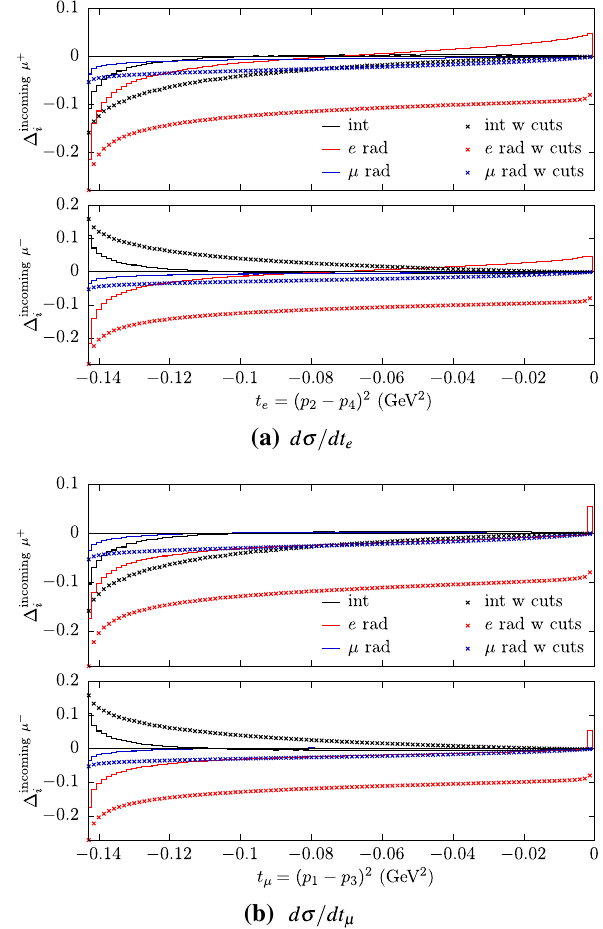
Fig. 13 The contribution of the QED gauge-invariant subsets to the cross section of the process μ + e − → μ + e − (upper panel) and of the process μ − e − → μ − e − (lower panel), as a function of the squared momentum transfer t e and t μ . The results refer to Setup 1 (solid lines) and Setup 2 (dotted lines) described in the